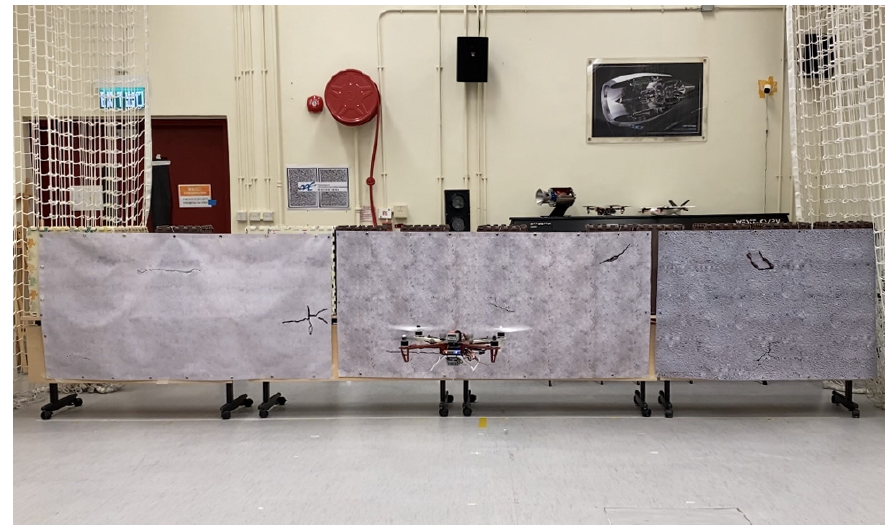
Figure 3. Experimental settings in the laboratory.